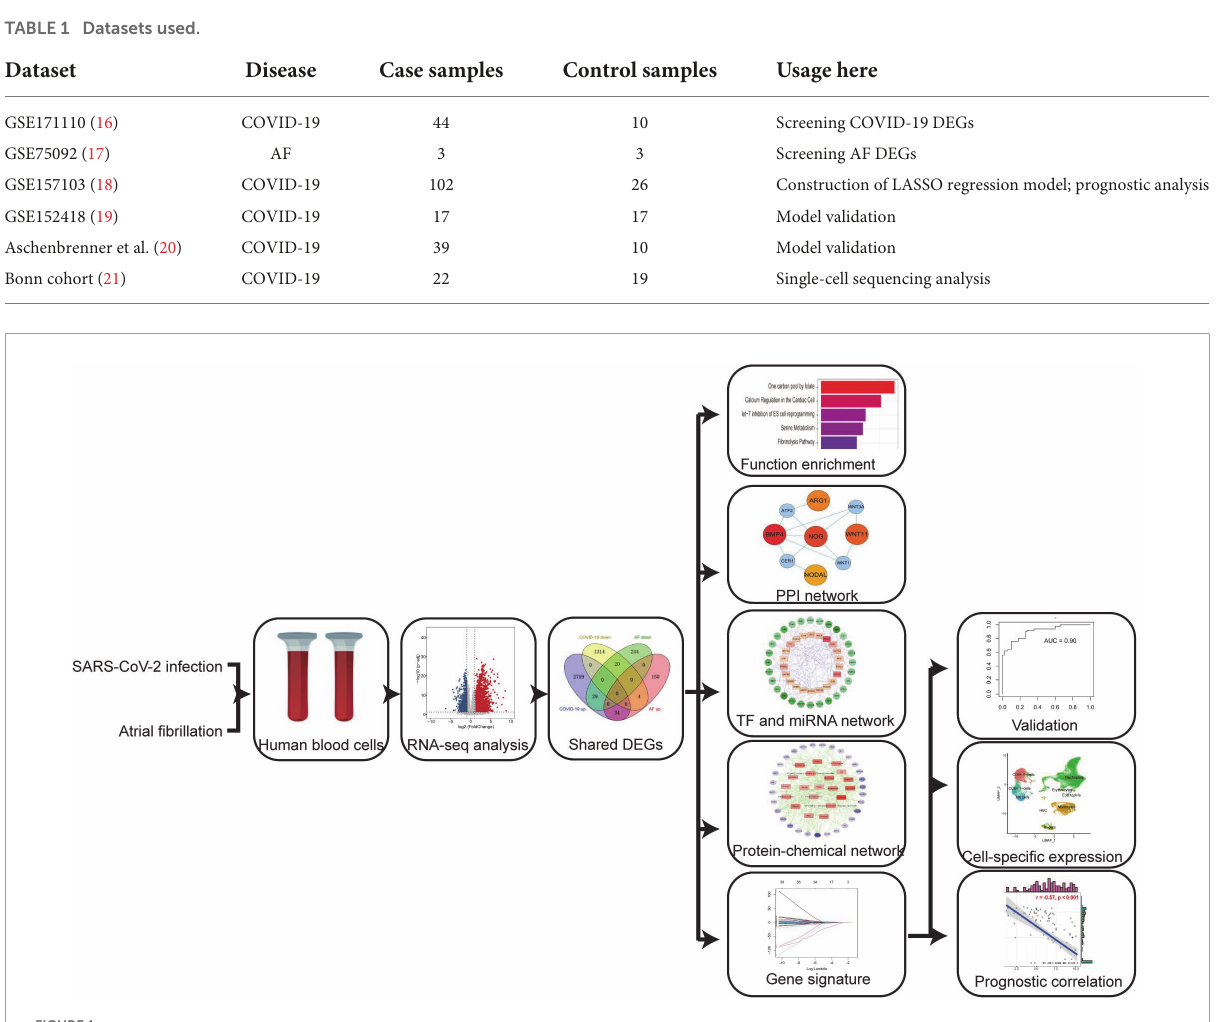
COVID-19 patients. The details of the study design are shown in a flowchart ( Figure 1